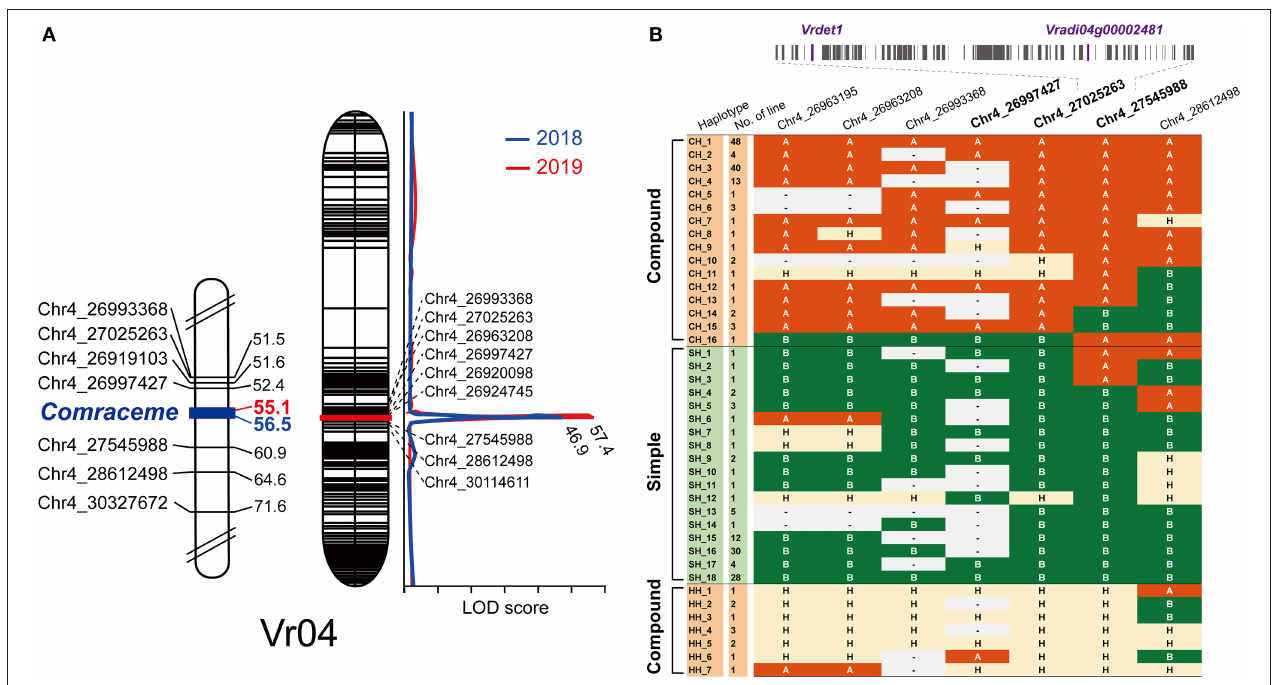
FIGURE 3 | Genetic mapping of the compound raceme of mungbean. (A) The position of the Comraceme locus for compound raceme. Comraceme was identified separately as a qualitative (left) and quantitative (right) trait using data collected during 2018 and 2019. It was located between markers Chr4_26997427 and Chr4_27545988 (left) and Chr4_26924745 and Chr4_27545988 (right). (B) SNP haplotypes around the Comraceme locus, the number of RILs by haplotype, and their phenotypical associations. Based on the phenotypic association of 3 haplotypes, CH_15, CH_16, and SH_1, the recombination break point was inferred to occur between Chr4_27025263 and Chr4_27545988, which corresponded to a physical length of 520.1Kb. RILs heterozygous for alleles around the Comraceme locus (haplotypes HH_1 to 7) showed the compound raceme type. The 64 protein-coding genes between the markers flanking the Comraceme locus are shown as small gray rectangles; Vrdet1 ( Vradi04g00002442 ) and Vradi04g00002481 are shown in purple. A (orange background): VC1973A allele; B (green background): IT208075 allele; H (yellow background): heterozygous allele.